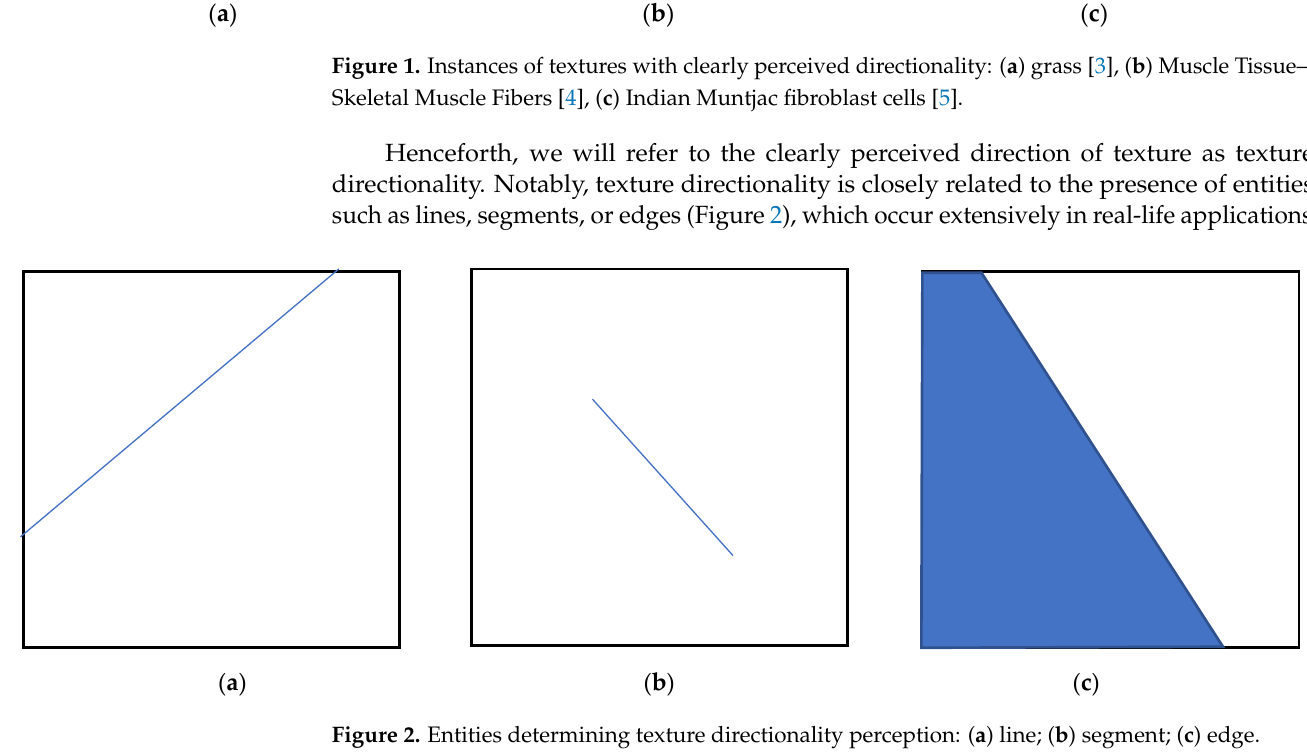
Figure 2. Entities determining texture directionality perception: ( a ) line; ( b ) segment; ( c ) edge.